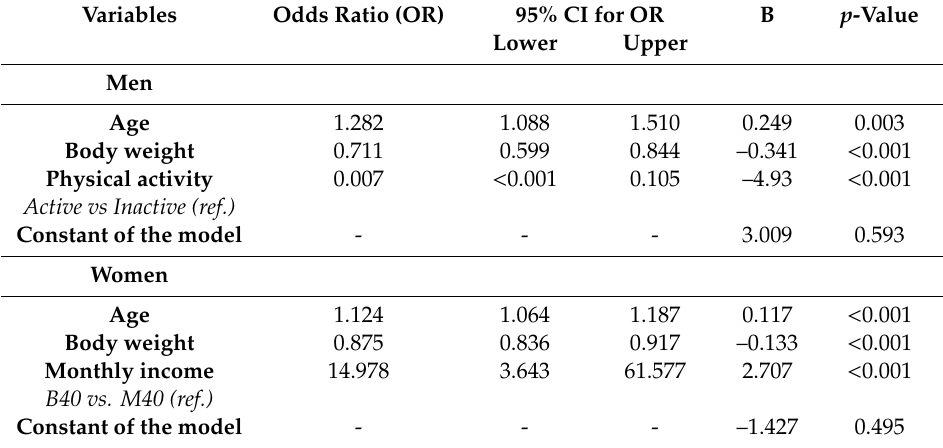
Table 3. Risk factors of